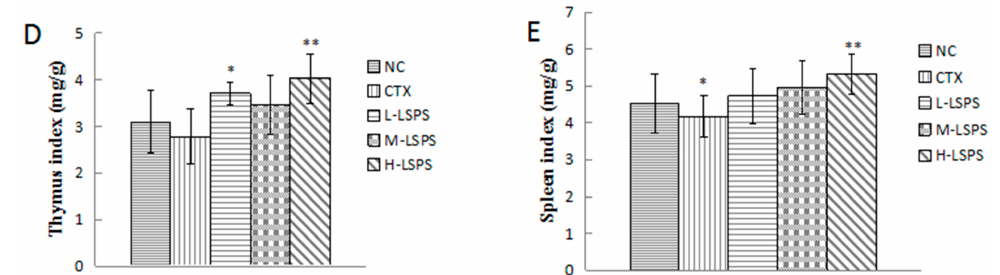
Figure 3. In vivo antitumor activities of LSPS in H22 tumor-bearing mice. Experiment design of H22 mouse hepatocellular carcinoma model ( A ); Effect of LSPS on tumor weight ( B ) and average tumor inhibition rate ( C ); Effect of LSPS on thymus index ( D ) and spleen index ( E ). The results are expressed as means ± SD of 10 separate experiments. Compared with negative control (NC), * p < 0.05, ** p < 0.01. CTX, cyclophosphamide (30 mg/kg) treated group; L-LSPS, lotus seed polysaccharide (50 mg/kg) treated group; M-LSPS, lotus seed polysaccharide (100 mg/kg) treated group; H-LSPS, lotus seed polysaccharide (200 mg/kg) treated group.